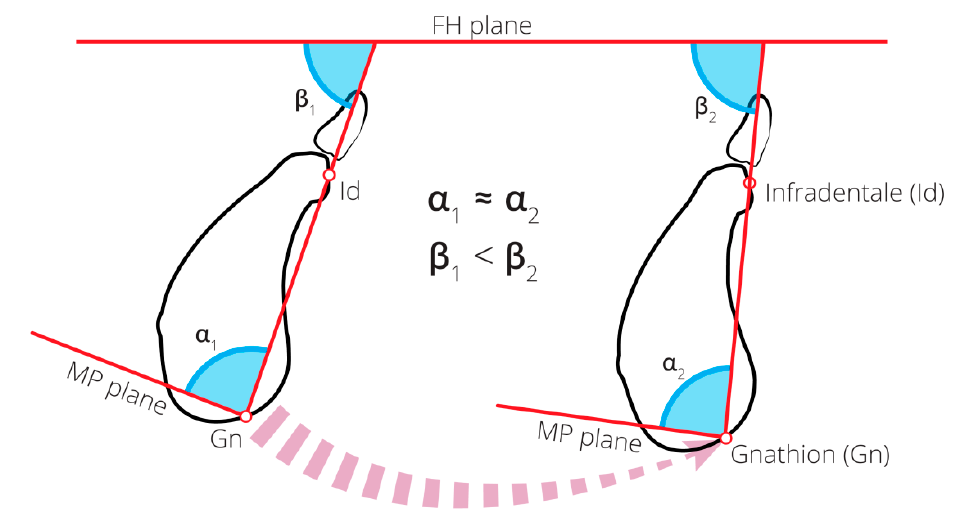
Figure 4. Changes in the symphysis orientation and inclination with age. The illustration on the left represents younger individuals, whereas the one on the right represents older individuals. No change in the symphysis inclination relative to the MP ( α angle) was evident ( α 1 is similar to α 2 ), whereas the symphysis orientation relative to the FH plane ( β angle) increased with age ( β 1 < β 2 ); this was probably due to a forward rotation of the mandible (arrow).